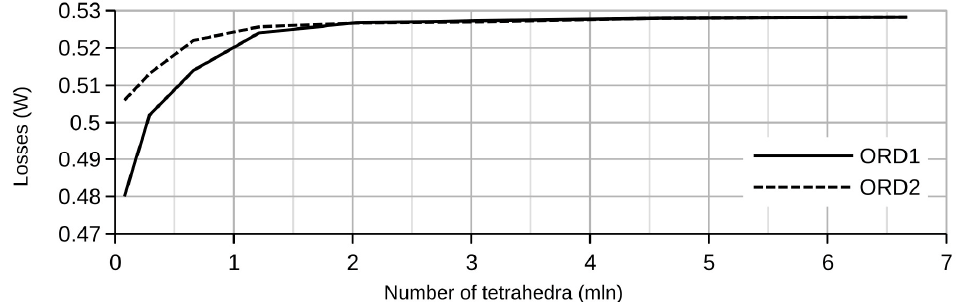
Figure 4. Dependence of the calculated value of eddy current losses (power) on the number of tetrahedrons in the finite element mesh when using first- and second-order elements.